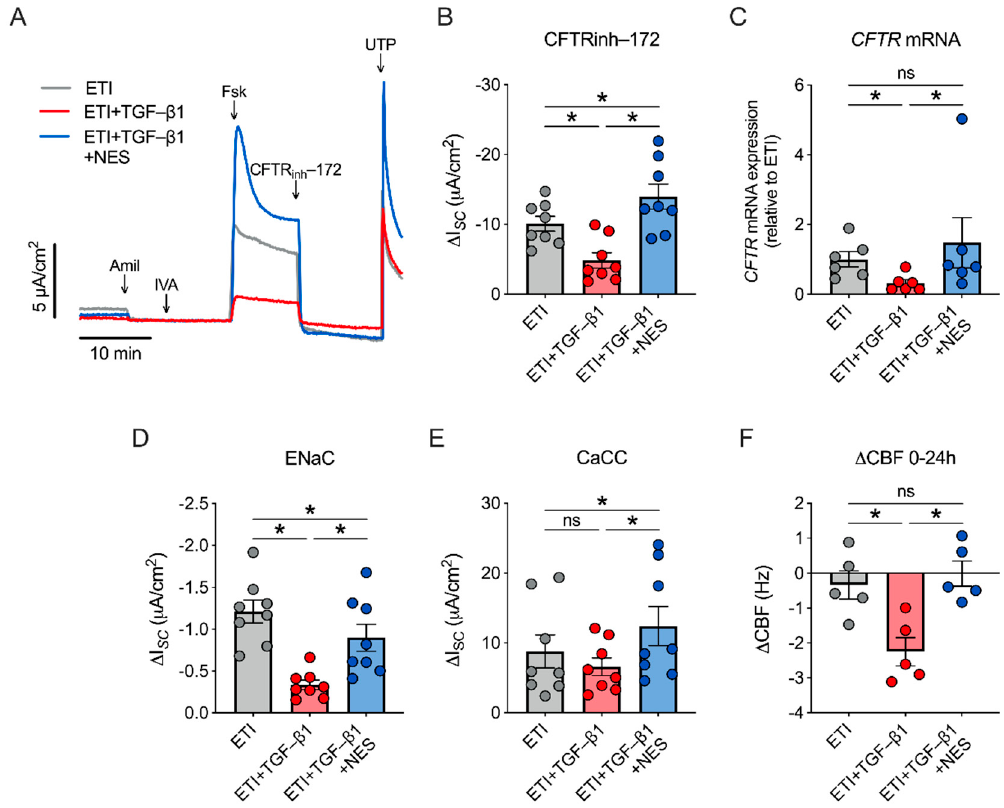
Figure 3. Nesolicaftor (NES) rescues TGF- β 1-induced reductions in CFTR function and ciliary beating in primary CFBE cells in vitro. ( A ) Fully differentiated ALI cultures of primary human CFBE cells homozygous for F508del were treated with elexacaftor (1 µ M)/tezacaftor (5 µ M)/ivacaftor (1 µ M) (ETI), ETI + TGF- β 1 (5 ng/mL), or ETI + TGF- β 1 + NES (10 µ M) for 24 h and CFTR-dependent I SC was measured in Ussing chambers. ( B ) Nesolicaftor reverses the reduction in ETI-corrected F508del CFTR function caused by TGF- β 1. n = 8, 3 CF lungs. ( C ) TGF- β 1 significantly reduces levels of CFTR mRNA expression in ETI-treated CFBE cells. CFTR mRNA levels are restored by nesolicaftor. n = 6, 3 CF lungs. ( D ) Amiloride-sensitive I SC (ENaC function) is significantly reduced by TGF- β 1. Nesolicaftor increases ENaC function in the presence of TGF- β 1. n = 8, 3 CF lungs. ( E ) TGF- β 1 does not significantly affect UTP-stimulated I SC (CaCC function). Nesolicaftor significantly increases CaCC function in the presence of TGF- β 1. n = 8, 3 CF lungs. ( F ) TGF- β 1 causes a significant reduction in ciliary beat frequency (CBF) in ETI-treated F508del CFTR CFBE cells after 24 h. TGF- β 1-induced reductions in CBF are reversed by nesolicaftor. n = 5, 3 CF lungs. Statistics: * p < 0.05, one-way ANOVA followed by Holm-Sidak ( B , D , F ) or Friedman test ( C , E ) after assessing normality with Shapiro-Wilk. ns = not